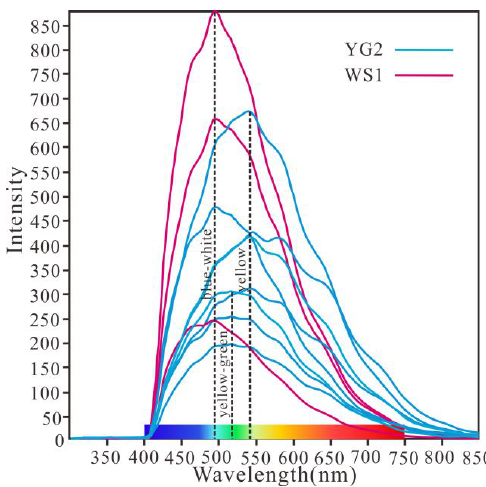
Figure 4. Fluorescence spectra of oil inclusions. The data are from wells WS1 and YG2 (see Table 1 for details). The horizontal and vertical lines show the wavelength and intensity of the fluorescence spectra.